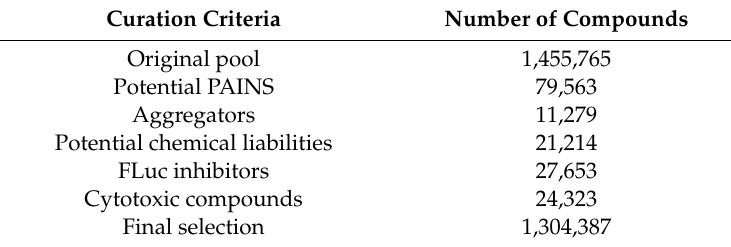
Table 1. Compound removal during data curation.